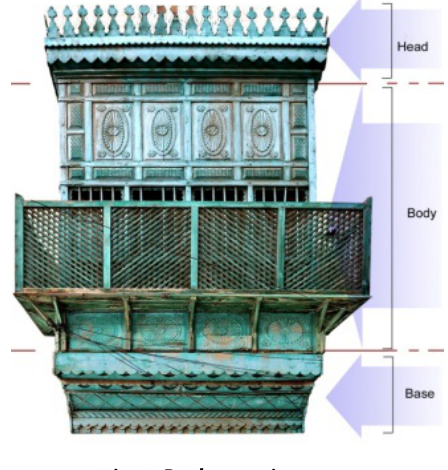
Fig .1 Roshan main parts adopted from Alitani (2011)